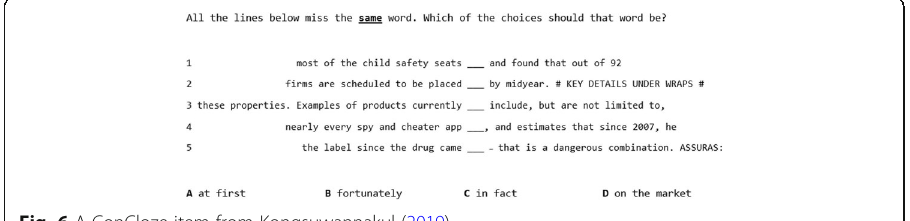
Fig. 6 A ConCloze item from Kongsuwannakul